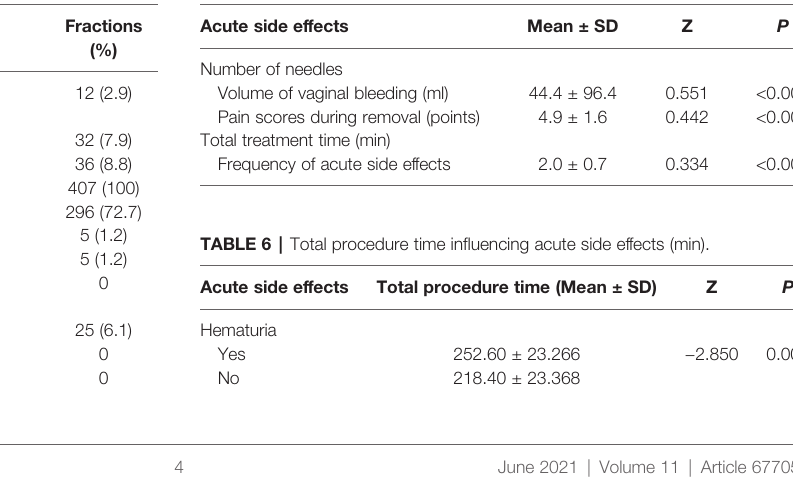
TABLE 4 | Classi fi cation and proportion of acute side effects. TABLE 5 | Factors in fl uencing acute side effects.